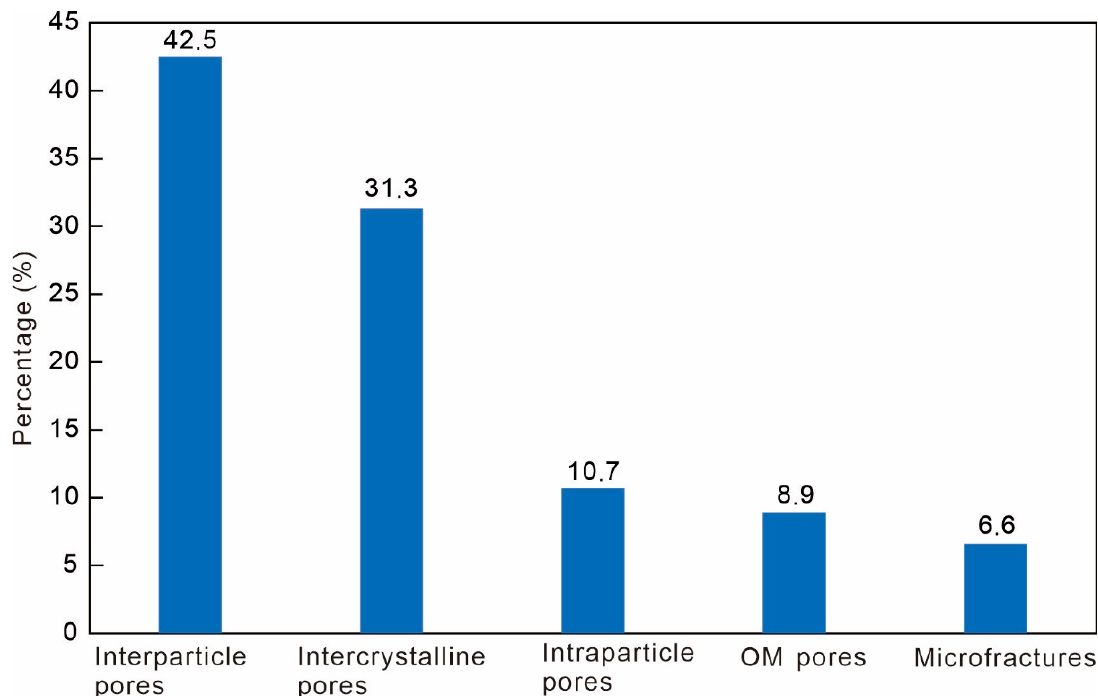
Figure 12. Histogram showing the percentages of different pore types.